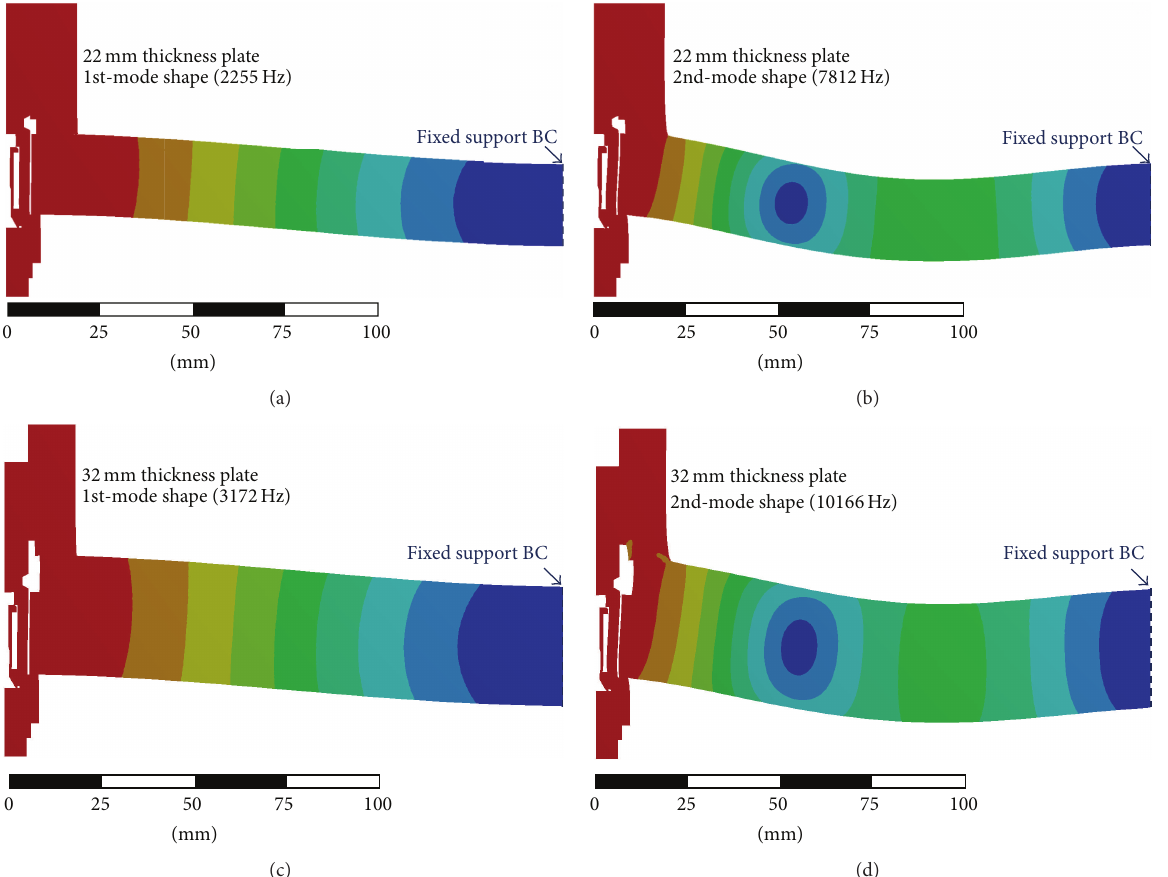
Figure 14: 2D axisymmetric modal analysis results: (a) 1st-mode shape of a bolt with a 22mm thickness circular plate, (b) 2nd-mode shape of bolt with a 22 mm thickness circular plate, (c) 1st-mode shape of a bolt with a 32 mm thickness circular plate, and (d) 2nd-mode shape of a bolt with a 32 mm thickness circular